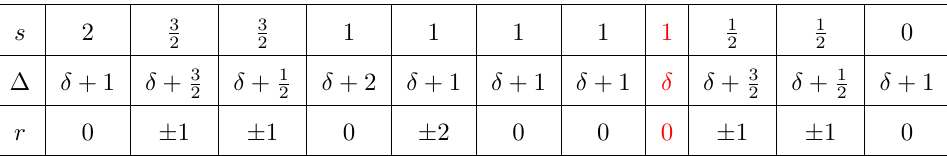
Table 2 . Spin s , conformal dimension ∆ , and R-charge r of the operators in the long L multiplet. The superconformal primary operator is indicated in